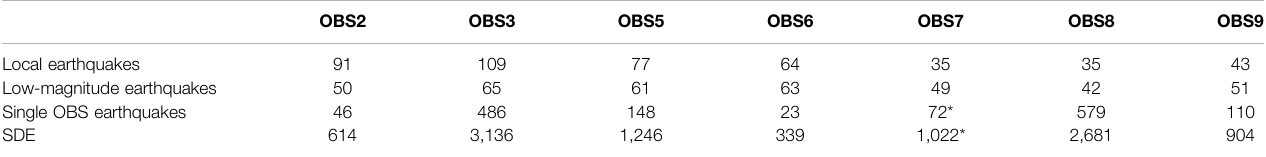
TABLE 2 | Number of integrated locations (on 133) of earthquakes recorded both by land and OBS stations, locations (on 76) of low-magnitude earthquakes recorded only by the OBS network, earthquakes and SDE recorded at the single OBS station. The asterisk in OBS7 indicates that this computation is up to 2018 February 28. OBS2